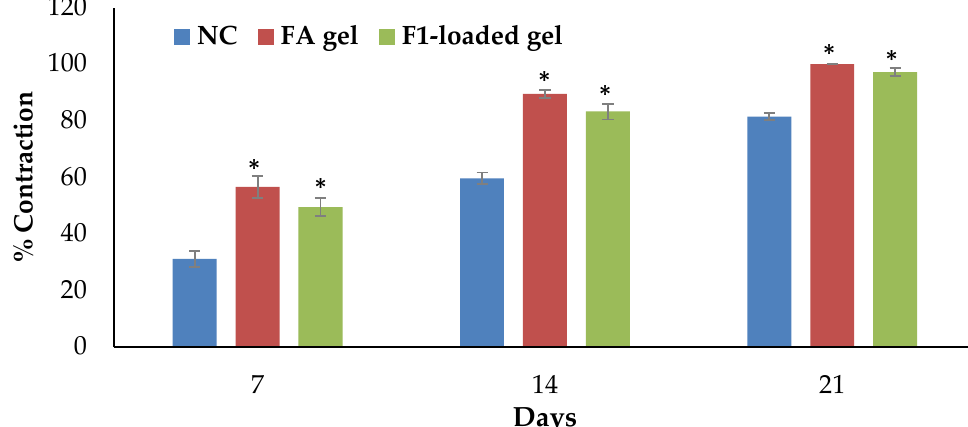
Figure 9. Percentage of wound contractions at various time intervals in the excision wound model in rats. Data are shown as the mean (S.E.M., n = 6 rats/group); significance is indicated by an asterisk (*) when compared to the NC group at p < 0.05.